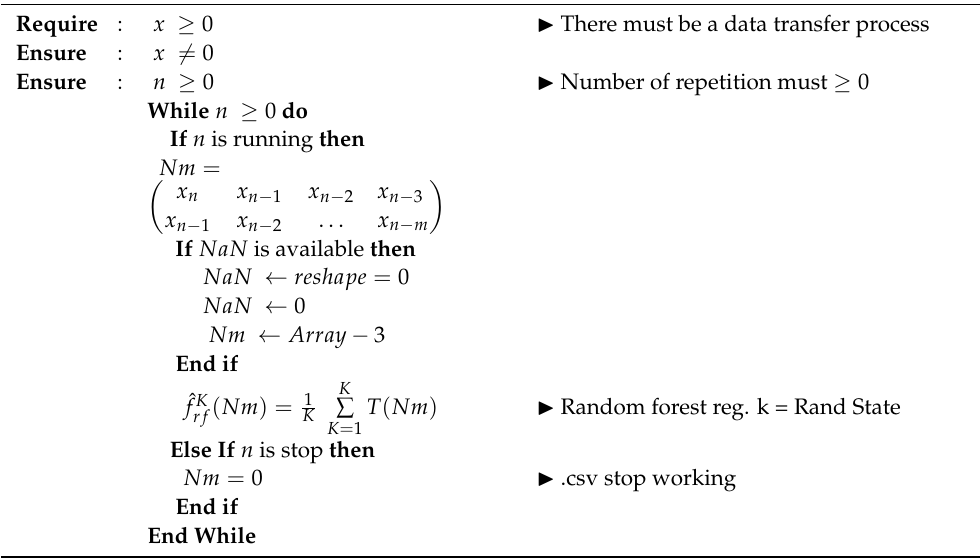
Algorithm 2. Machine Learning Prediction